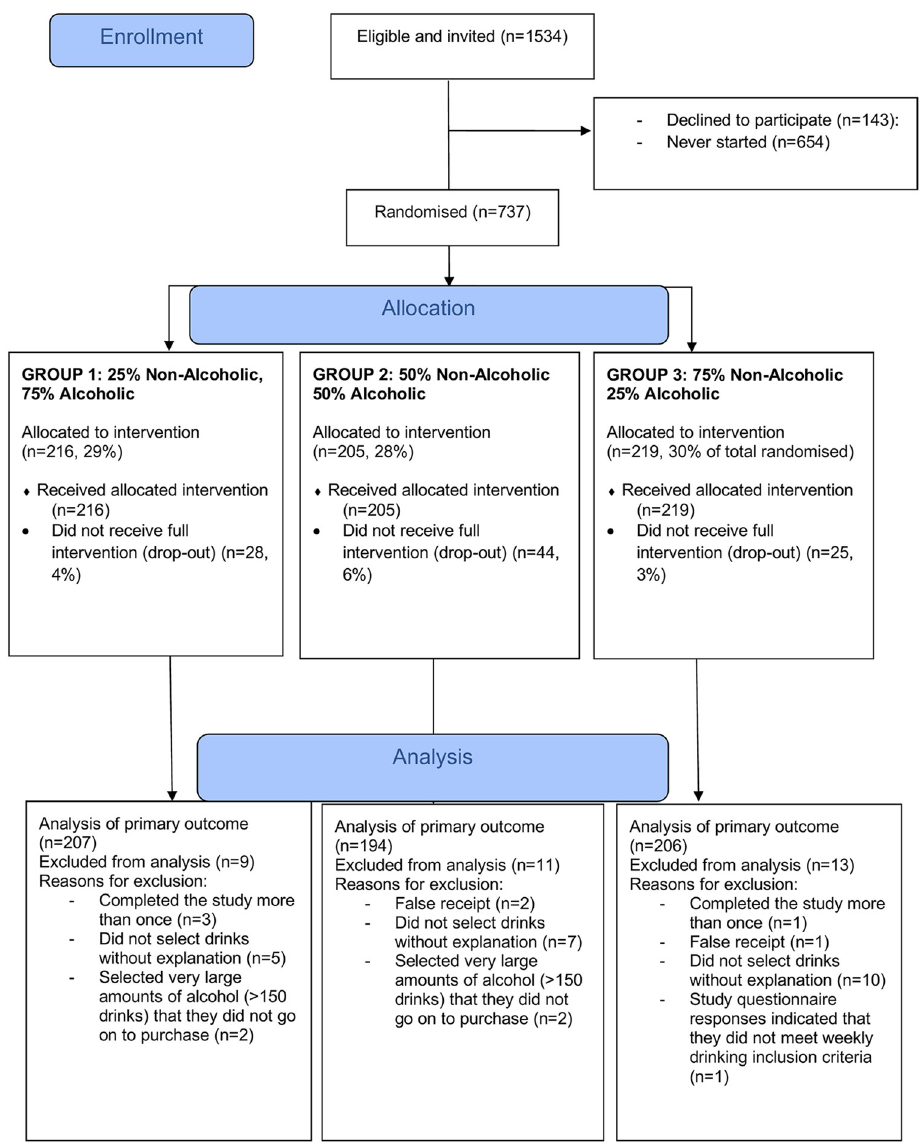
Fig 1. Participant flowchart. non-alcoholic group” and the “25% non-alcoholic” group (95% CI − 1.44, 0.17; p = 0.121). In the second part of a hurdle model in participants (559/607) selecting any drinks containing alcohol, the “75% non-alcoholic” group selected fewer alcohol units compared to the “50% non-alcoholic” (95% CI − 0.44, − 0.14; p < 0.001) and “25% non-alcoholic” (95% CI − 0.54, − 0.24; p < 0.001) groups, with no evidence of a difference between the “50% non-alcoholic” and “25% non-alcoholic” groups (95% CI − 0.24, 0.05; p = 0.178). Overall, across all partici- pants, 17.46 units (95% CI 15.24, 19.68) were selected in the “75% non-alcoholic” group; 25.51 units (95% CI 22.60, 28.43) in the “50% non-alcoholic” group; and 29.40 units (95% CI 26.39, 32.42) in the “25% non-alcoholic” group. This corresponds to 8.1 fewer units (32% reduction) in the “75% non-alcoholic” group compared to the “50% non-alcoholic” group, and 11.9 fewer